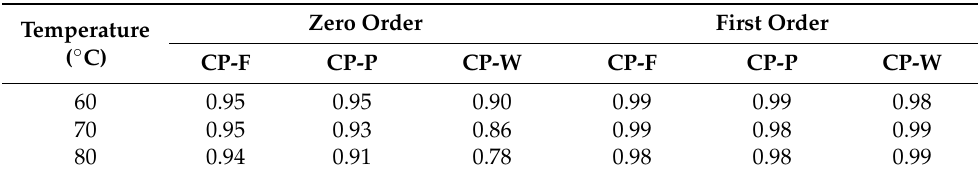
Table 1. The r 2 values of a linear regression from zero and first order plots of carbamide peroxide (CP) degradation by heat exposure.